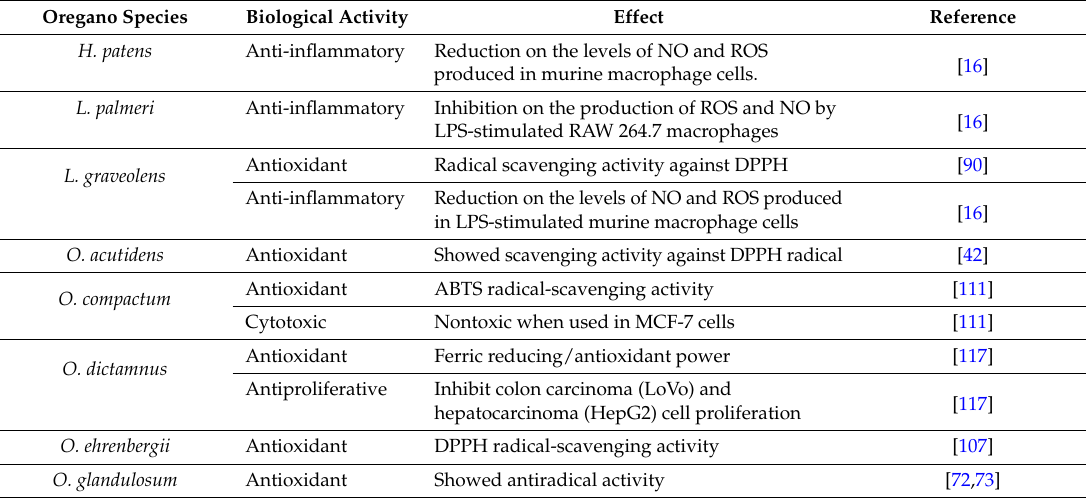
Table 2. Summarization of the biological activities of essential oils from